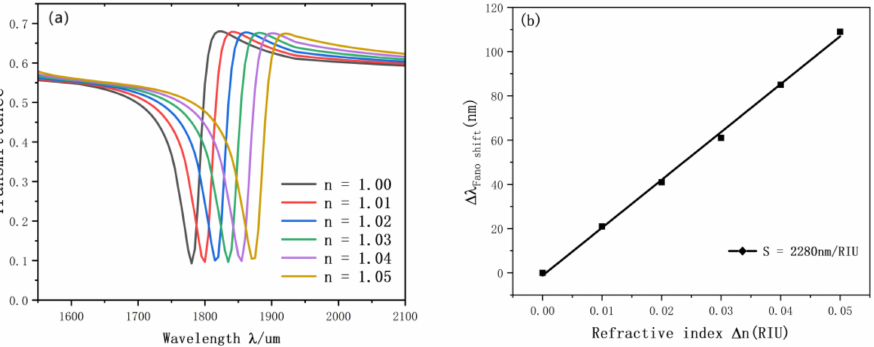
Figure 6. ( a ) Transmission spectrum of g variation; ( b ) the sensitivity of n changes to fit the line. Subsequently, we study whether the Fano resonance curve will have different changes when the radius of the SRRDR is selected. The radius R1 varies from 190 nm to 230 nm. The transmission spectrum and sensitivity curve of the SRRDR are shown in Figure 7a. The most obvious one is that with the continuous increase of radius, the transmission spectrum will undergo continuous red shift, and the transmittance and FWHM will fluctuate slightly. In addition, we also perform linear fitting according to the resonance curves of different radii. As shown in Figure 7b, the radius of the coupling ring keeps increasing, and the sensitivity of the sensor also increases. This shows that R1 can have a great influence on the tilt wavelength. When R1 = 230 nm, the maximum sensitivity is 2280 nm/RIU. FOM was 76.7.